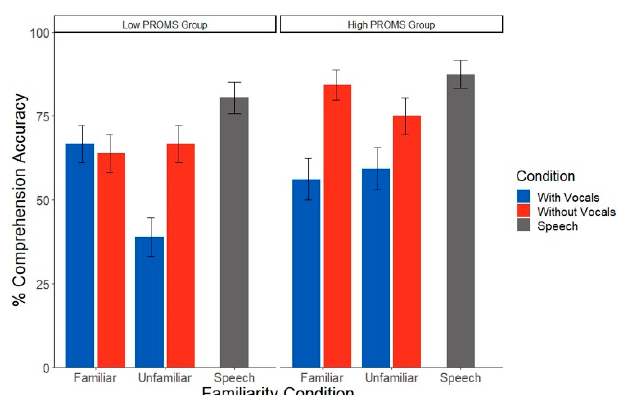
Figure 4. Speech comprehension performance varies with listeners’ musical skill level. Less musical listeners performed worse in music with vocals only in the unfamiliar music condition. However, more musical listeners did not show any effects of familiarity or song condition. PROMS = Profile of Music Perception Skills test. Error bars represent ± 1 standard error of the mean.